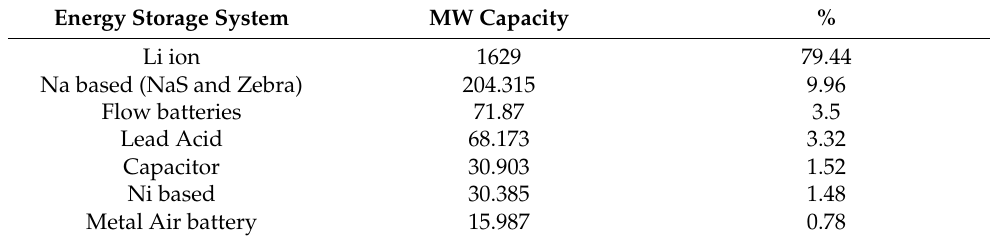
Table 1. Operational capacity for electrochemical and electrical energy storage systems [22].